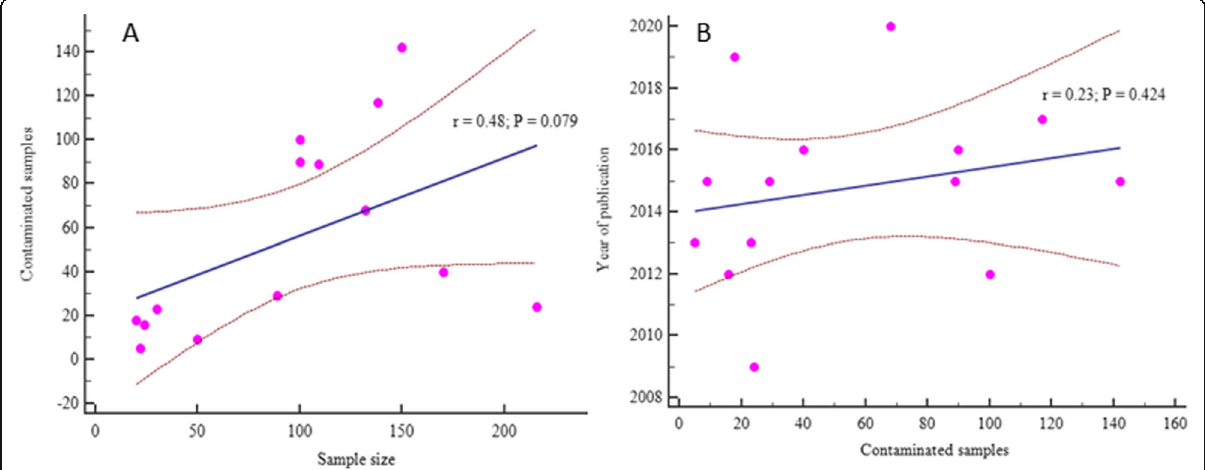
Fig. 11 Meta-regression analysis by sample size and contaminated samples ( a ) and by year of publication and bacteriologically contaminated HM samples ( b ), sold in E. Africa from 2000 to 2020